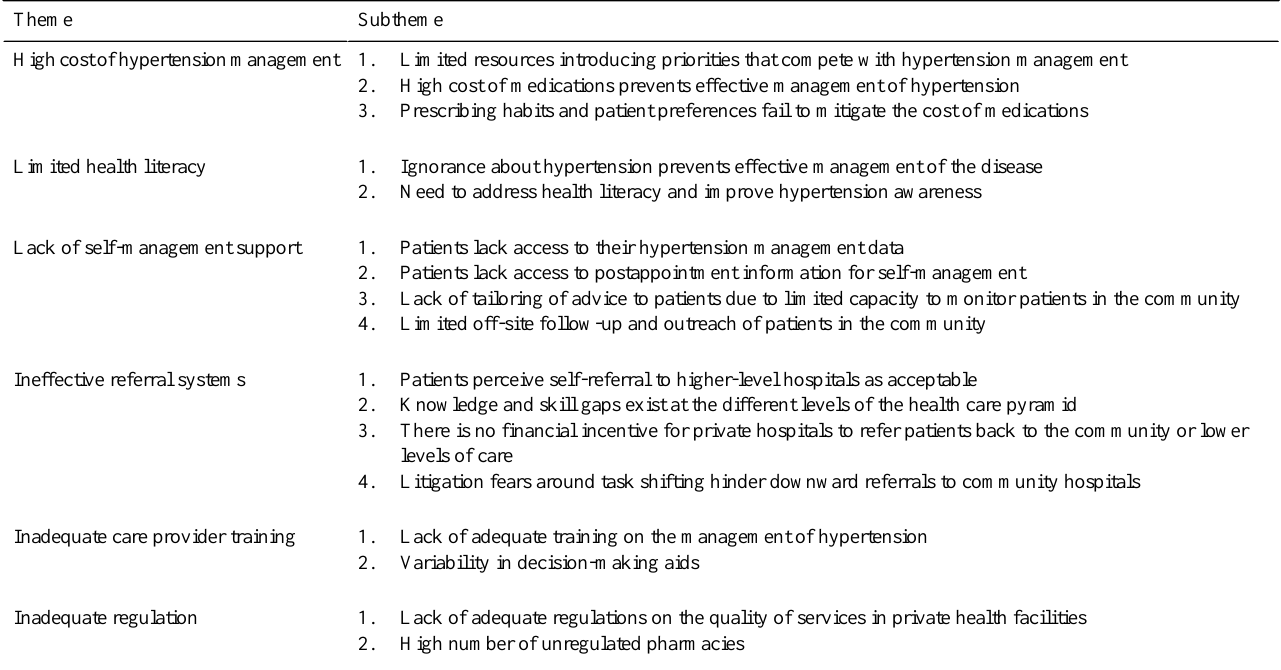
Table 1. Themes and subthemes about the management of hypertension in the private health care sector in Kenya.